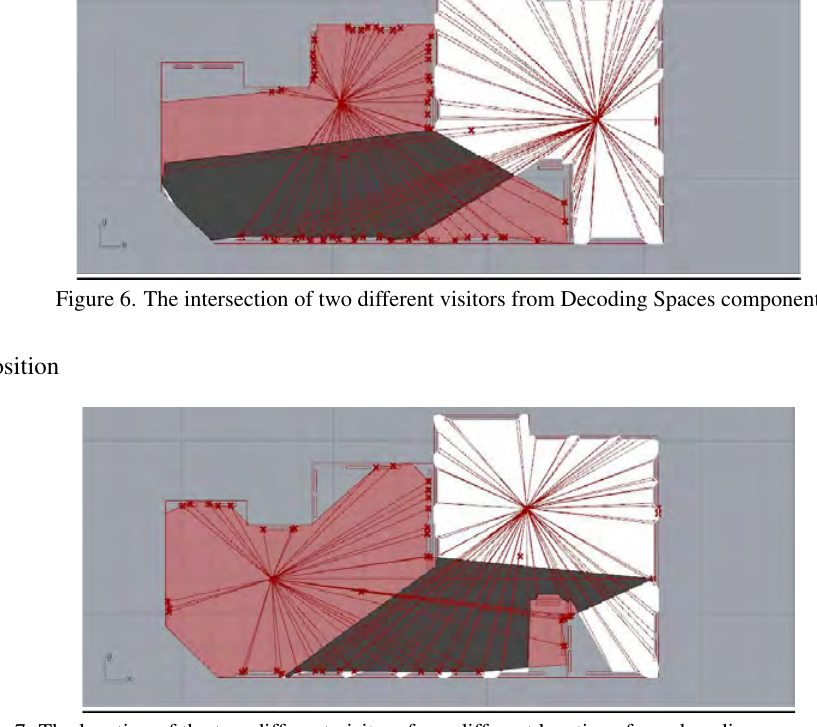
Figure 7. The location of the two different visitors from different locations from decoding spaces